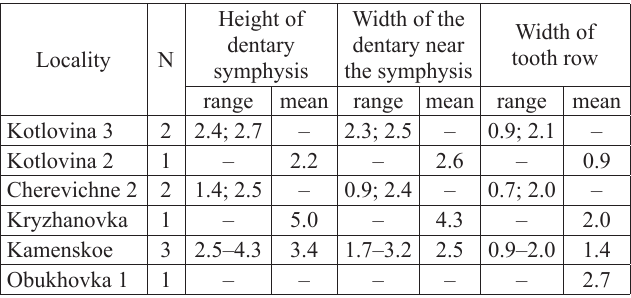
Table 3. Measurements (in mm) of dentaries of Esox moldavicus Sytchevskaya, 1974. N, number of